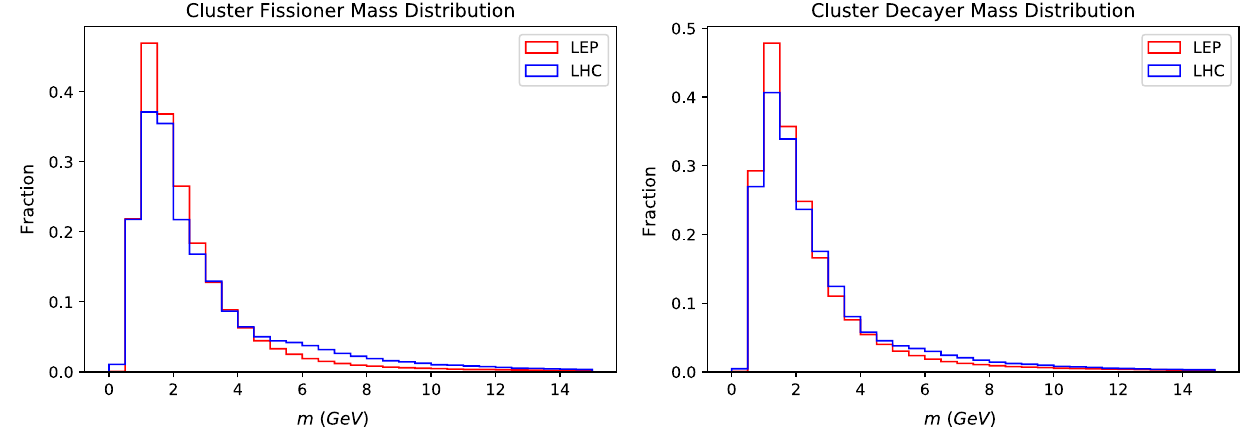
Fig. 5 Comparison of LEP and LHC Minimum Bias mass spectra of clusters immediately before cluster fission and cluster